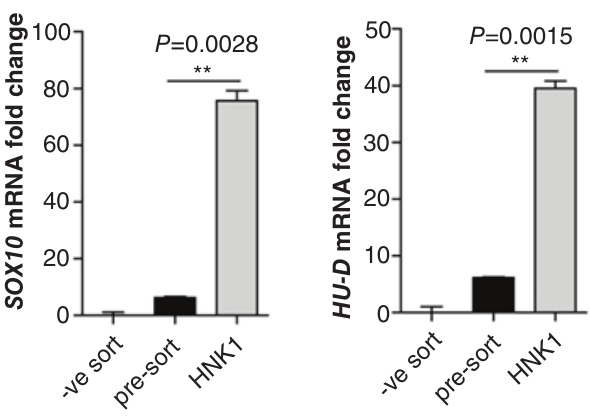
Supplemental Figure S1. QE5 and QE8 midgut ENS donor tissue. Intestine (midgut) caudal to the gizzard (giz.) to about half way along the cacum (cec.) was obtained. This was removed from E5 (about HH27) and E8 quail embryos (about HH34-35). HH34-35 midgut was also obtained from 9-day chick embryos. The intestine was cut at the dorsal border of the mesentery to exclude cells of the Nerve of Remak. The tissue used did not include the cecal root because here the Nerve of Remak is applied to the gut so closely that contamination is unavoidable. C-r = colo-rectum, prov. = proventriculus